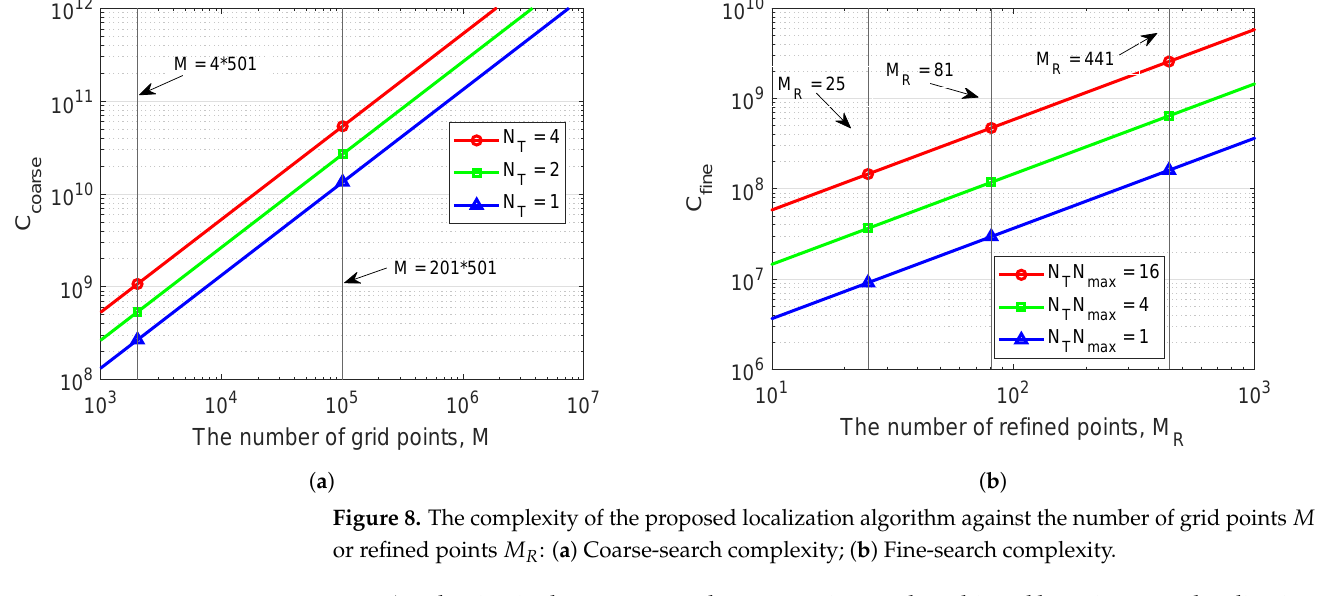
Figure 8. The complexity of the proposed localization algorithm against the number of grid points M or refined points M R : ( a ) Coarse-search complexity; ( b ) Fine-search